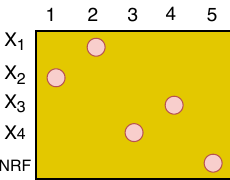
Figure 3. Illustration of the equivalent channel matrix ˜ H of size N RF × N RF